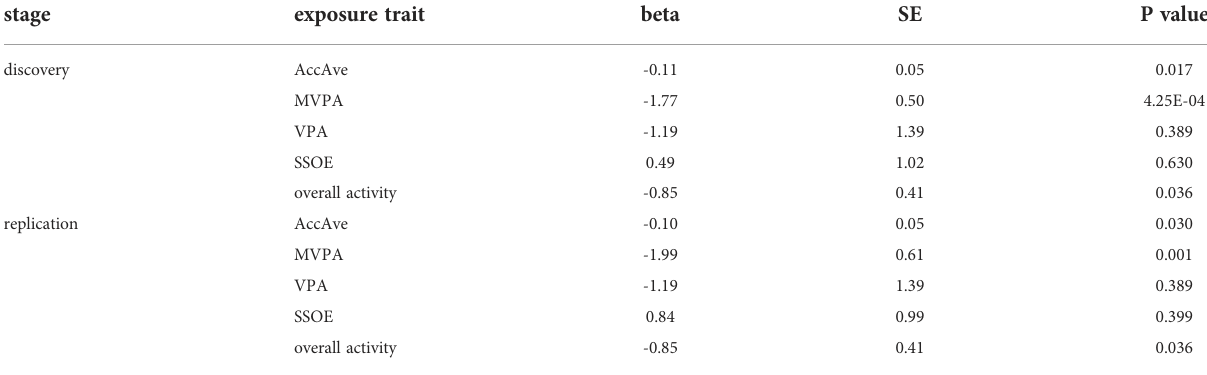
TABLE 2 Mendelian randomization estimates between physical activity and multiple sclerosis adjusting for body mass index.